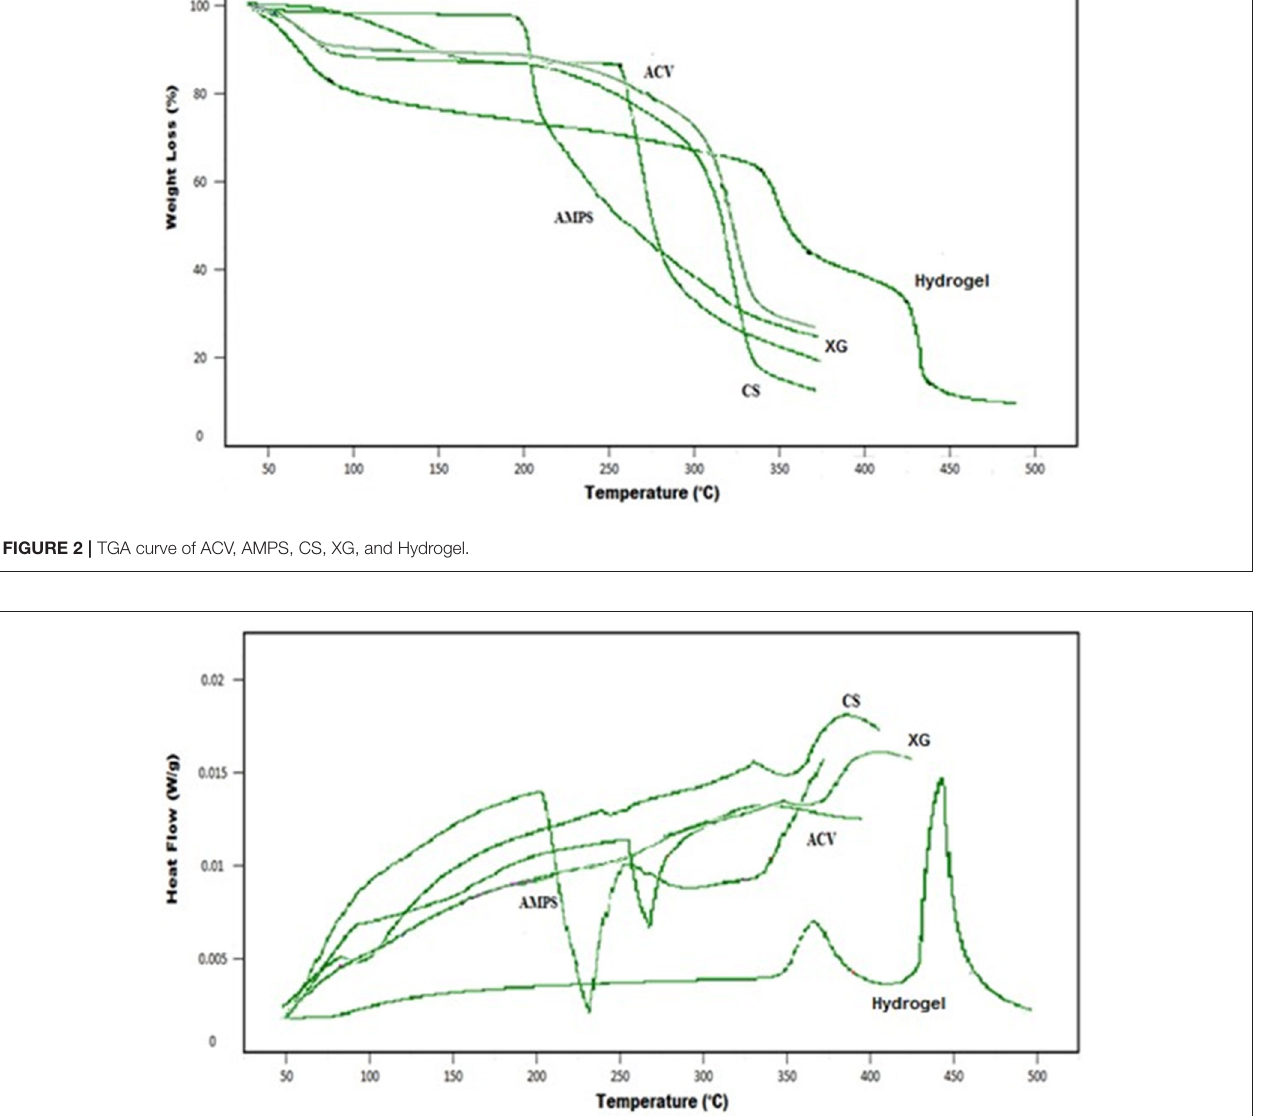
Frontiers in Chemistry |